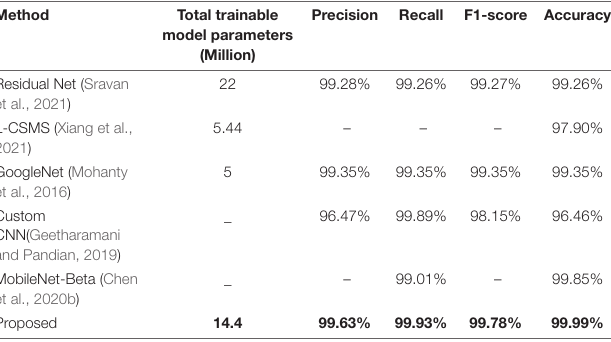
TABLE 6 | Performance analysis of proposed method with recent